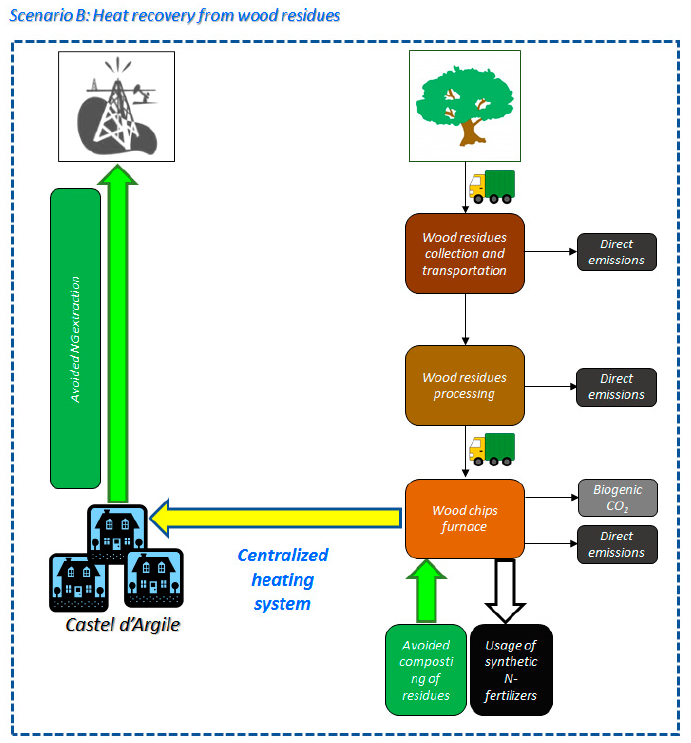
Figure 3. System boundaries LCA for ( A ) the current heating system and ( B ) the alternative bio-based system.